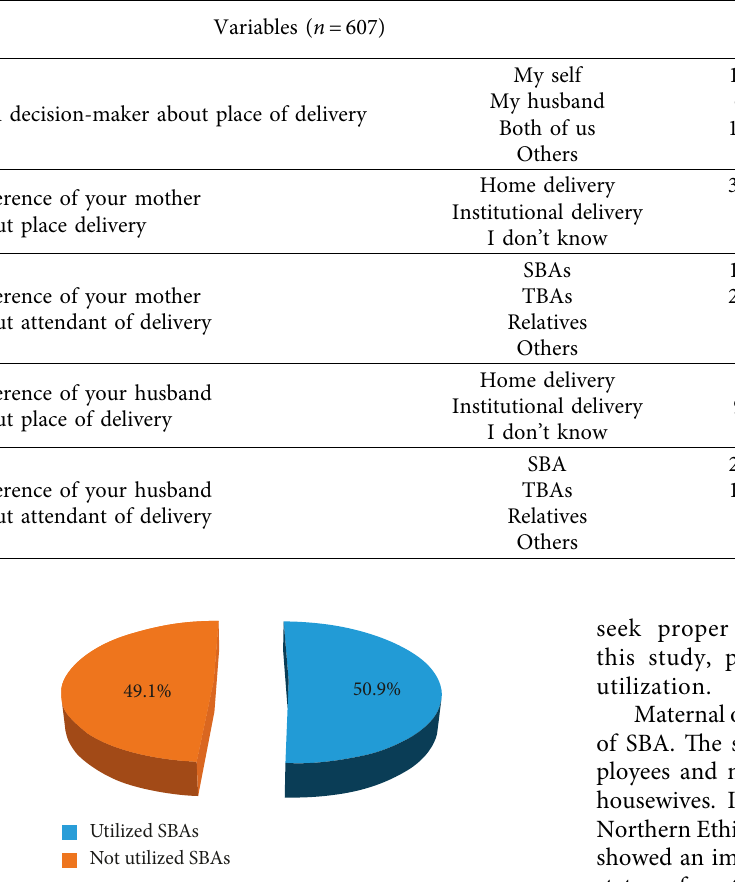
Figure 2: Utilization of SBA of respondents in the Kembata Tembaro zone,